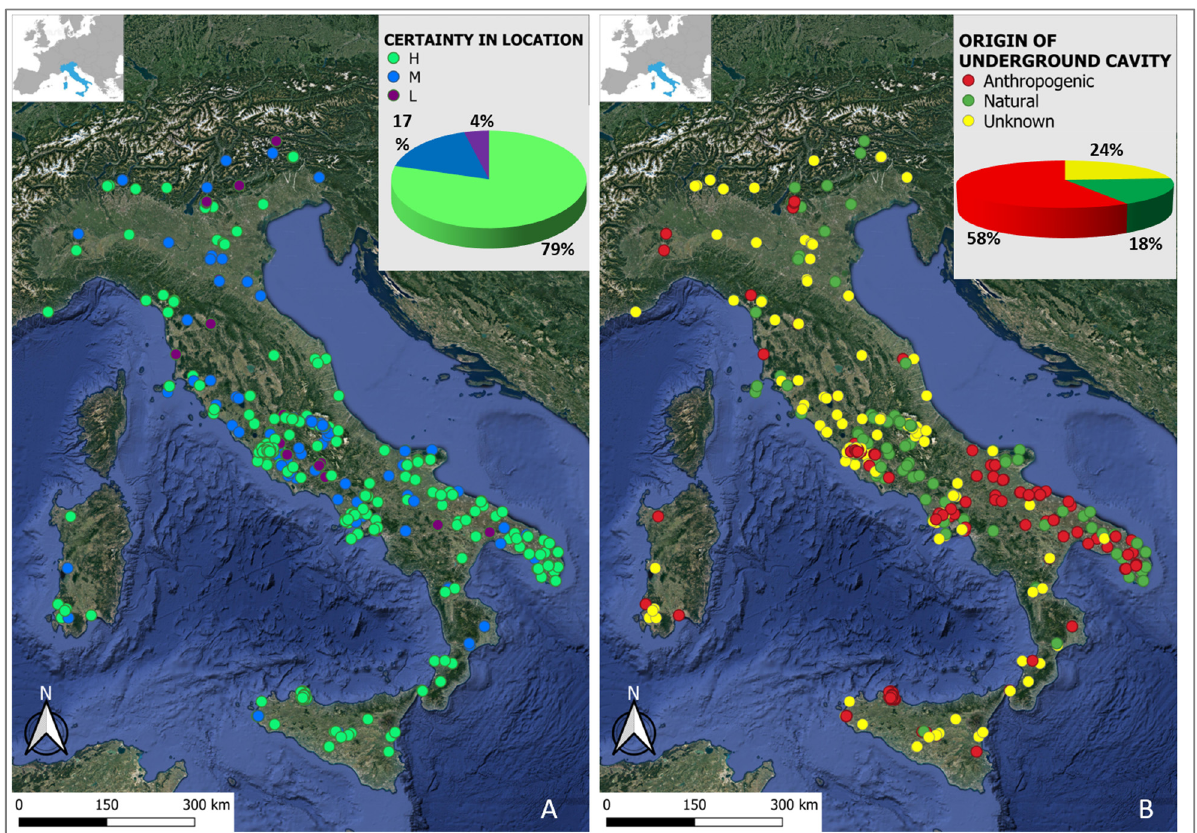
Figure 6. Distribution of the sinkholes documented in the catalogue in the Italian regions; ( A ) following the certainty in location classes (H—high; M—Medium; L—Low; see Table 2 for details), ( B ) following the origin of underground cavity.